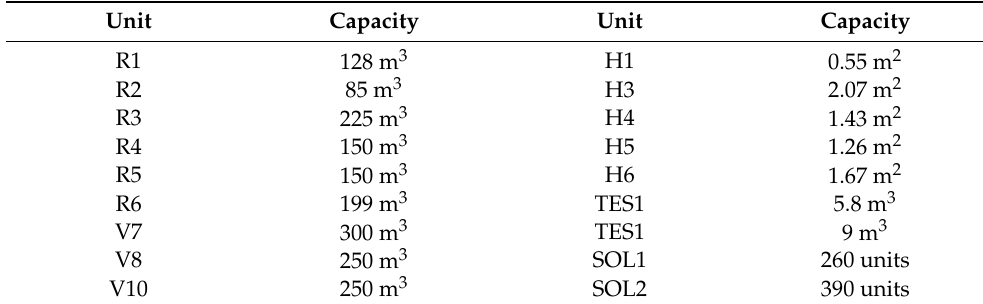
Figure 12. Optimal scheduling and batch processing solution. Table 8. Optimal scheduling and batch processing solution.